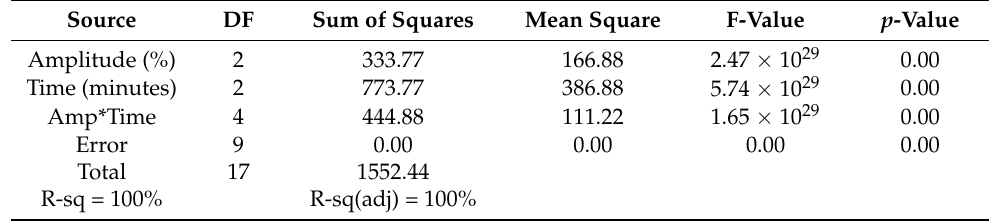
Table 3. ANOVA analysis for compressive strength (CS).